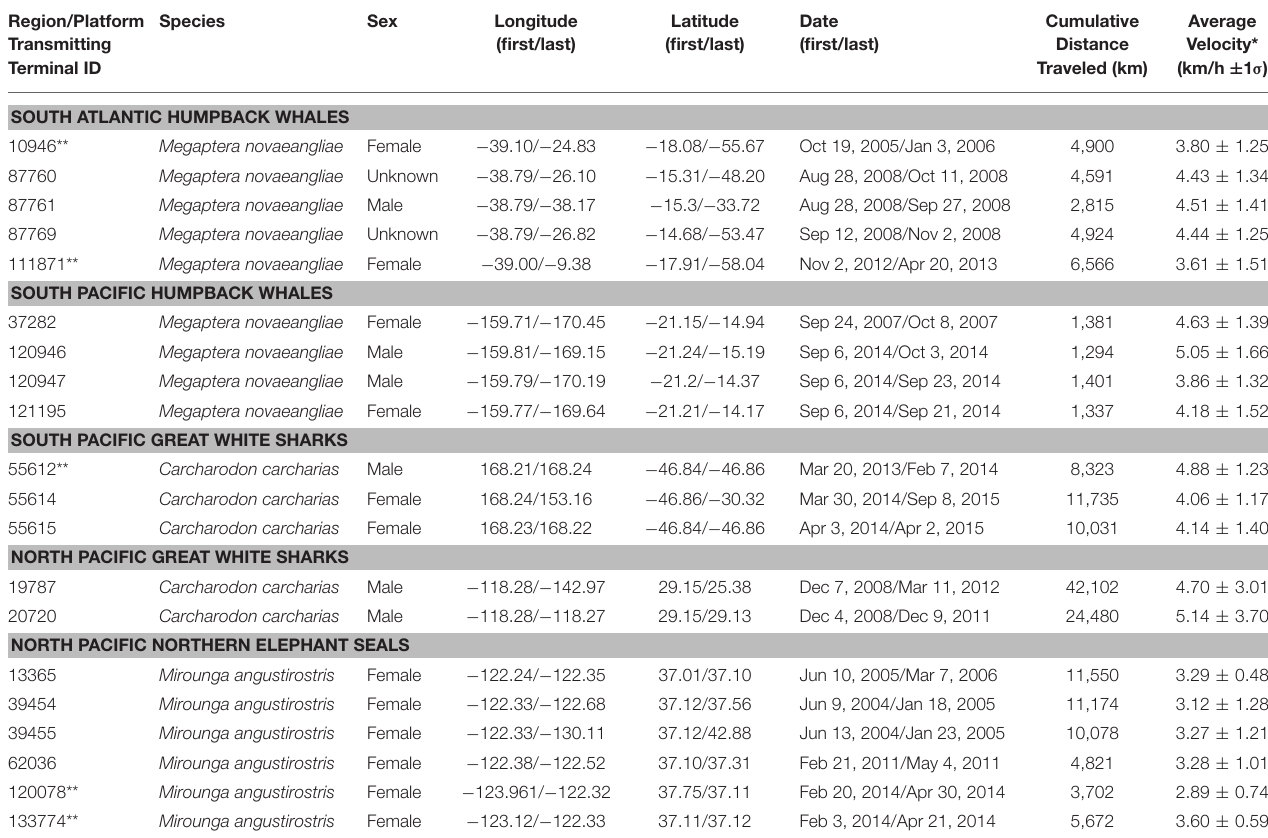
TABLE 1 | Platform transmitting terminal (PTT) tag deployment information. Region/Platform Transmitting